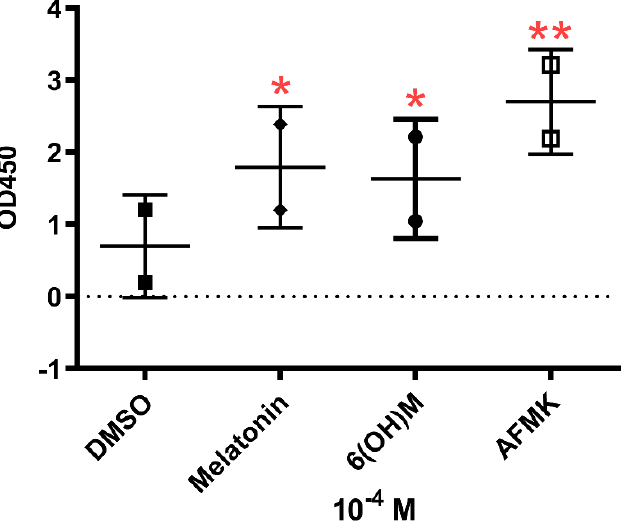
Figure 5. Changes in telomerase activity in epidermal HaCaT keratinocytes under influence of melatonin, 6-hydroxymelatonin or AFMK at a concentration of 10 − 4 M. The plots represent all values with calculated means and significance was evaluated by paired Student t -Test with * p < 0.05; ** p < 0.01.